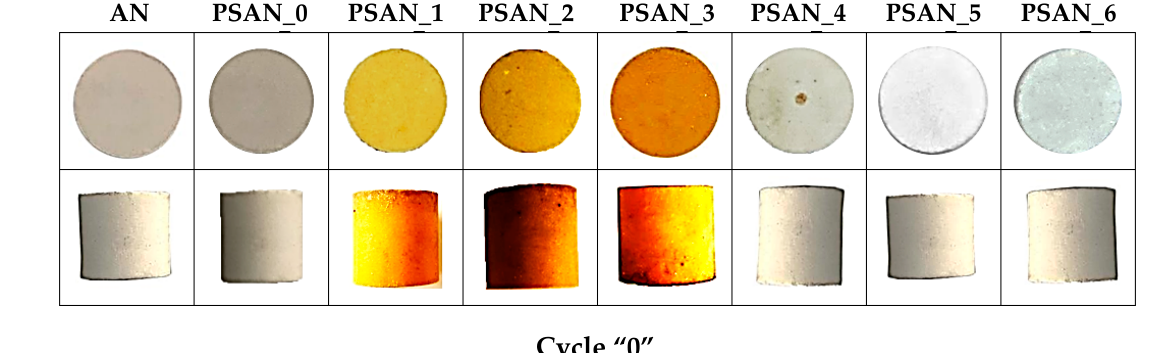
Figure 6. Volume variation for the sample containing neat AN and PSAN_6 after four heating–cool- ing cycles ( V C4 —volume after cycle “4”; V C0 —initial volume).